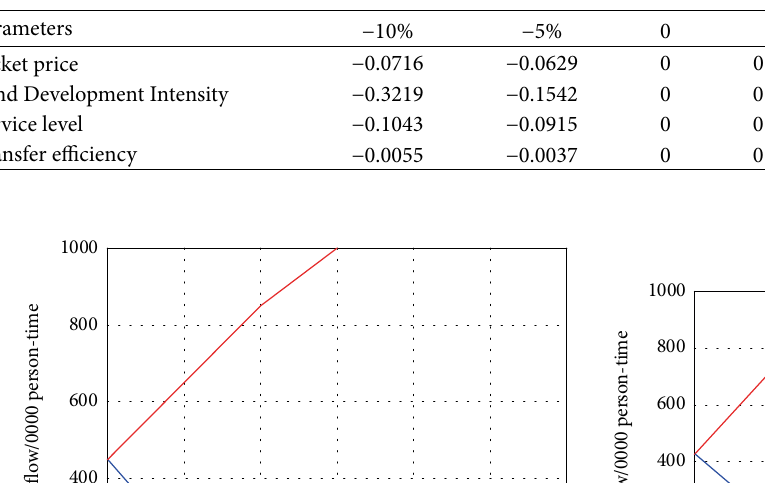
10The plot ratio = 0.1 The plot ratio =